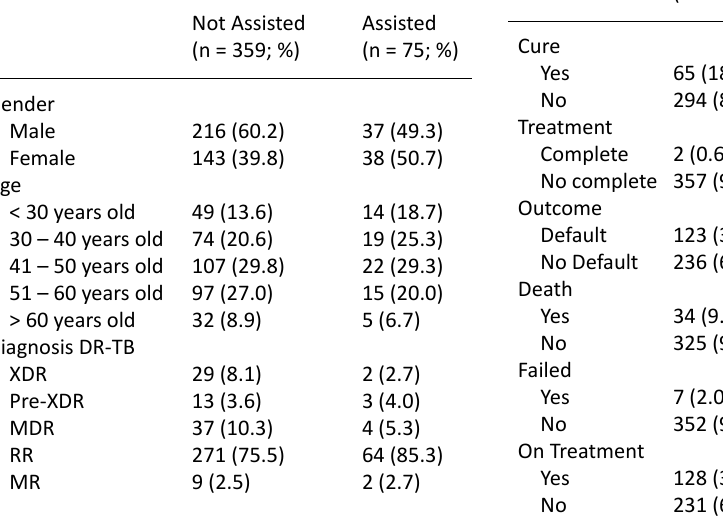
Table 2. Demography of DR-TB patients